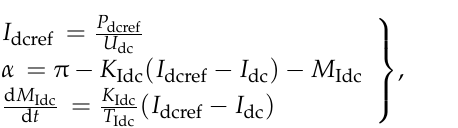
Figure 6. Comparisons of the improved/conventional MMC electromechanical model with the detailed electromagnetic model.